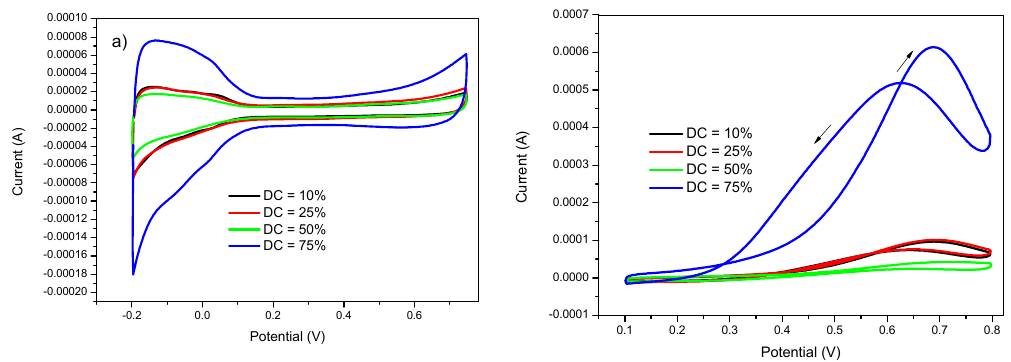
Figure 6. Cyclic voltammetry in ( a ) 0.5 M H 2 SO 4 and in ( b ) 2 M methanol +0.5 M H 2 SO 4 of GC/PANI(CV)/PtNPs electrodes obtained at various duty cycles (DC) = 10, 25, 50, and 75 %.